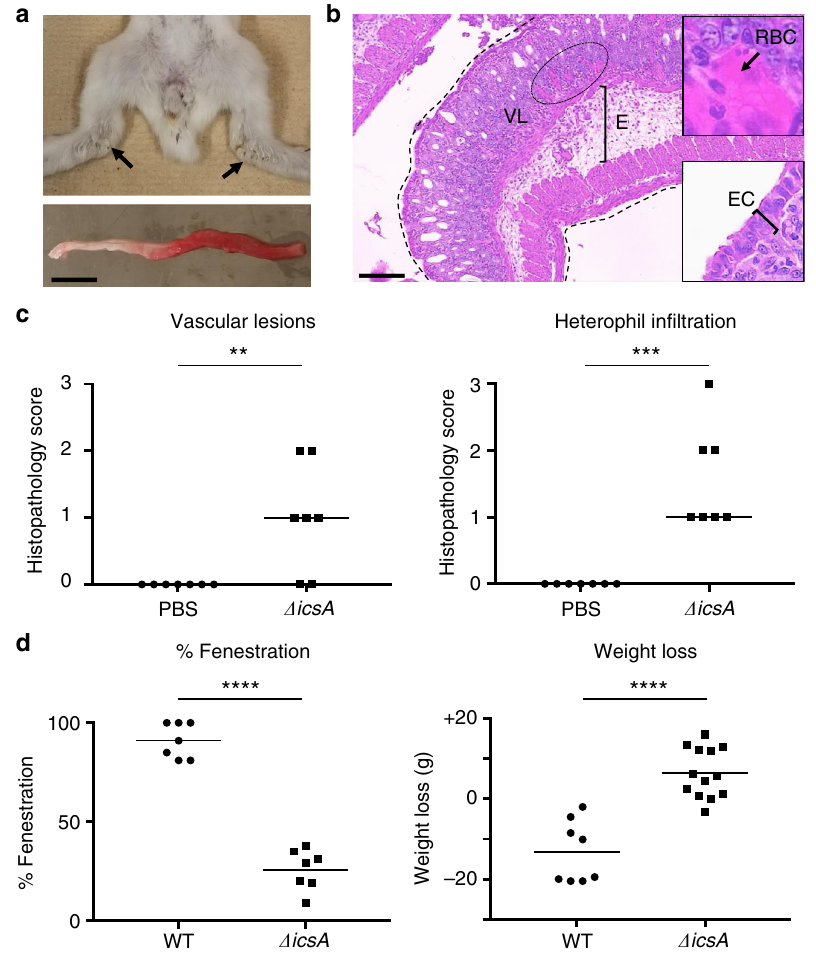
Fig. 6 Symptoms and histopathology in absence of cell-to-cell spread. a Representative images of animals (top) and colon (bottom) inoculated with the Δ icsA mutant. Arrows indicate tarnished fur. Scale bar, 2 cm. b Representative image of hematoxylin- and eosin-stained colonic sections from animals inoculated with the Δ icsA mutant. Dotted lines delineate the colon. E, edema; VLs, vascular lesions. Insets: (top) high magni fi cation of red blood cells (RBCs) indicative of VLs and (bottom) high magni fi cation of epithelial cells (ECs). Scale bar, 100 μ m. c Histopathology scores of VLs) and heterophil in fi ltration (HI). Statistical analysis: unpaired Student ’ s t test. Δ icsA vs. mock (phosphate-buffered saline (PBS): VLs, ** P < 0.01; ***HI, P < 0.05. d Graphs showing the percentage of epithelial fenestration (EF) and weight loss (WL). Statistical analysis, unpaired t test. Δ icsA vs. S. fl exneri (wild type (WT)): EF, **** P < 0.0001; WL, **** P < 0.0001. Source data are provided as a Source Data fi Table 1. The scoring system evaluates VLs, sub-mucosal edema, EF, heterophil in fi ltration, and monocyte in fi ltration. Percentage of EF for each individual sample was calculated using the Leica LAS X imaging software: EF = (length of colonic epithelium with signs of fenestration/total length of colonic epithelium) × 100. Colonic RNA extraction . At the appropriate time point, the colon was removed from euthanized animals and placed directly in 6ml of TRIzol (Thermo Fisher Scienti fi c, 15596026) in a 50ml falcon tube. Samples were homogenized in TRIzol using the Tissue Master 125 Lab Homogenizer with a 7mm probe (Omni Inter- national, TM125-115). One milliliter of the TRIzol homogenate was placed into a 1.5 ml microfuge tube containing 200 μ l of chloroform. Samples were vigorously shaken, incubated at room temperature for 2 – 3min, and centrifuged at 12,000 rcf for 10 min. Five hundred microliters of the aqueous (top) phase was placed into a